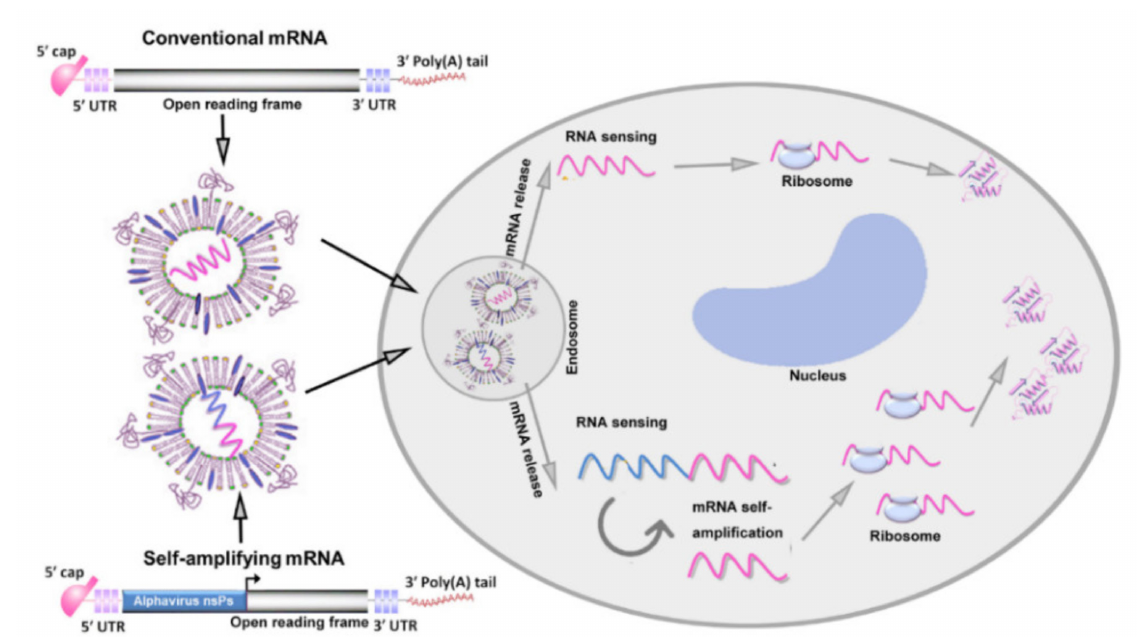
Figure 3. Mechanism of mRNA vaccine cancer therapy. Both conventional mRNAs and self- amplifying mRNAs (saRNAs) encoding antigen proteins are encapsulated in NPs and delivered into cells through the cell membrane. Then, they are trafficked into the endosomes. Only a small fraction of these mRNA-containing NPs escape endosomes and are released into the cytoplasm. Conventional mRNA is sensed by the cell and translated through ribosomes into antigen proteins that can induce an immune response. saRNA undergoes self-amplification that is facilitated by nonstructural proteins (nsPs), leading to the translation of more